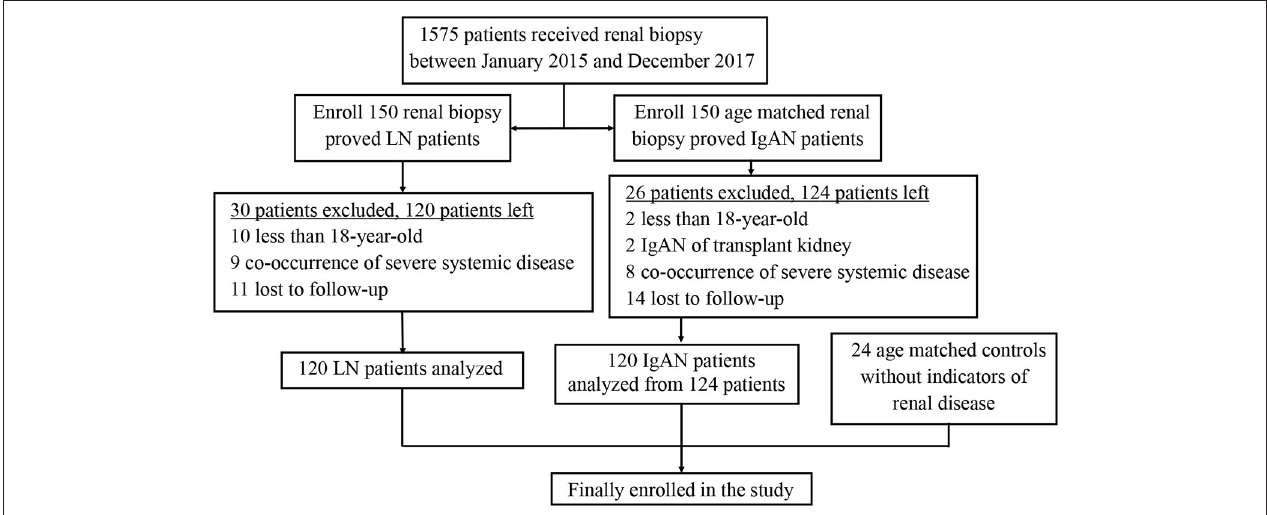
FIGURE 1 | Flow diagram of the study design. A total of 120 LN patients, 120 IgAN patients and 24 healthy controls were enrolled into the study. LN, lupus nephritis; IgAN, IgA nephropathy.